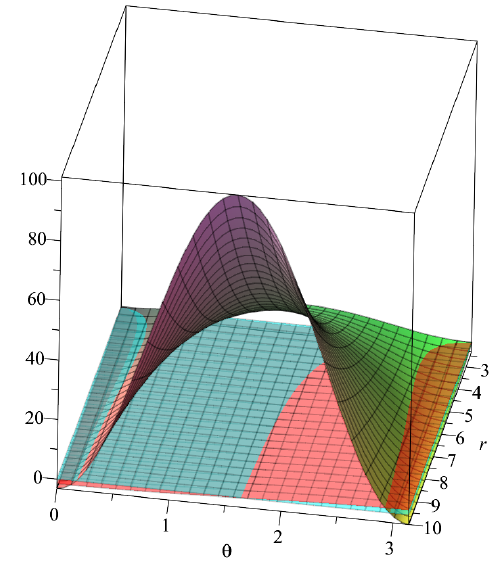
Figure 3. The function g φφ for the Kerr–Taub–NUT solution becomes negative at the poles (the zero plane is shown in cyan), where there exist CTCs. The function g t φ is plotted in red: it is positive near the south pole but negative at the north pole, indicating that CTCs are counter-rotating near the south pole but co-rotating at the north pole (both with respect to the horizon). The choice of parameters are M = n = 1, a =